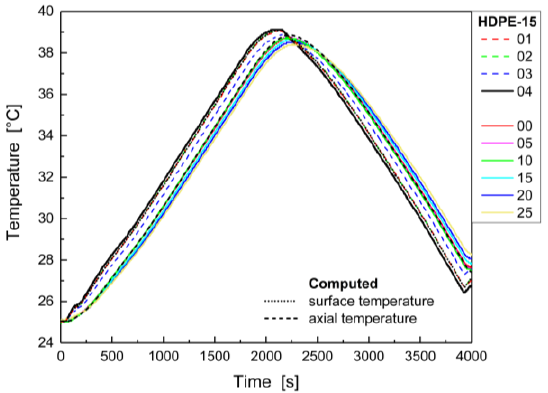
Figure 23. Time-history of measured temperatures and computed surface and axial temperatures (measurement B — temperature increase in climate chamber by 15 °C/probe 2).